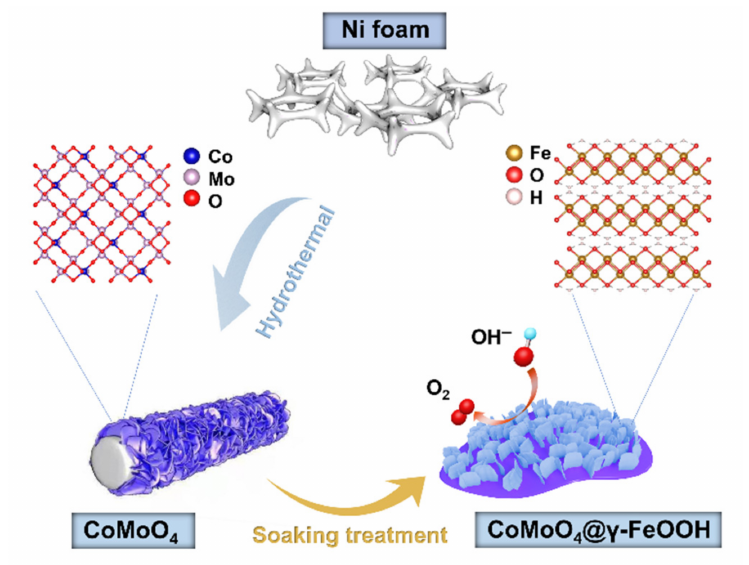
Figure 1. Schematic illustration for the construction of CoMoO 4 @ γ -FeOOH OER